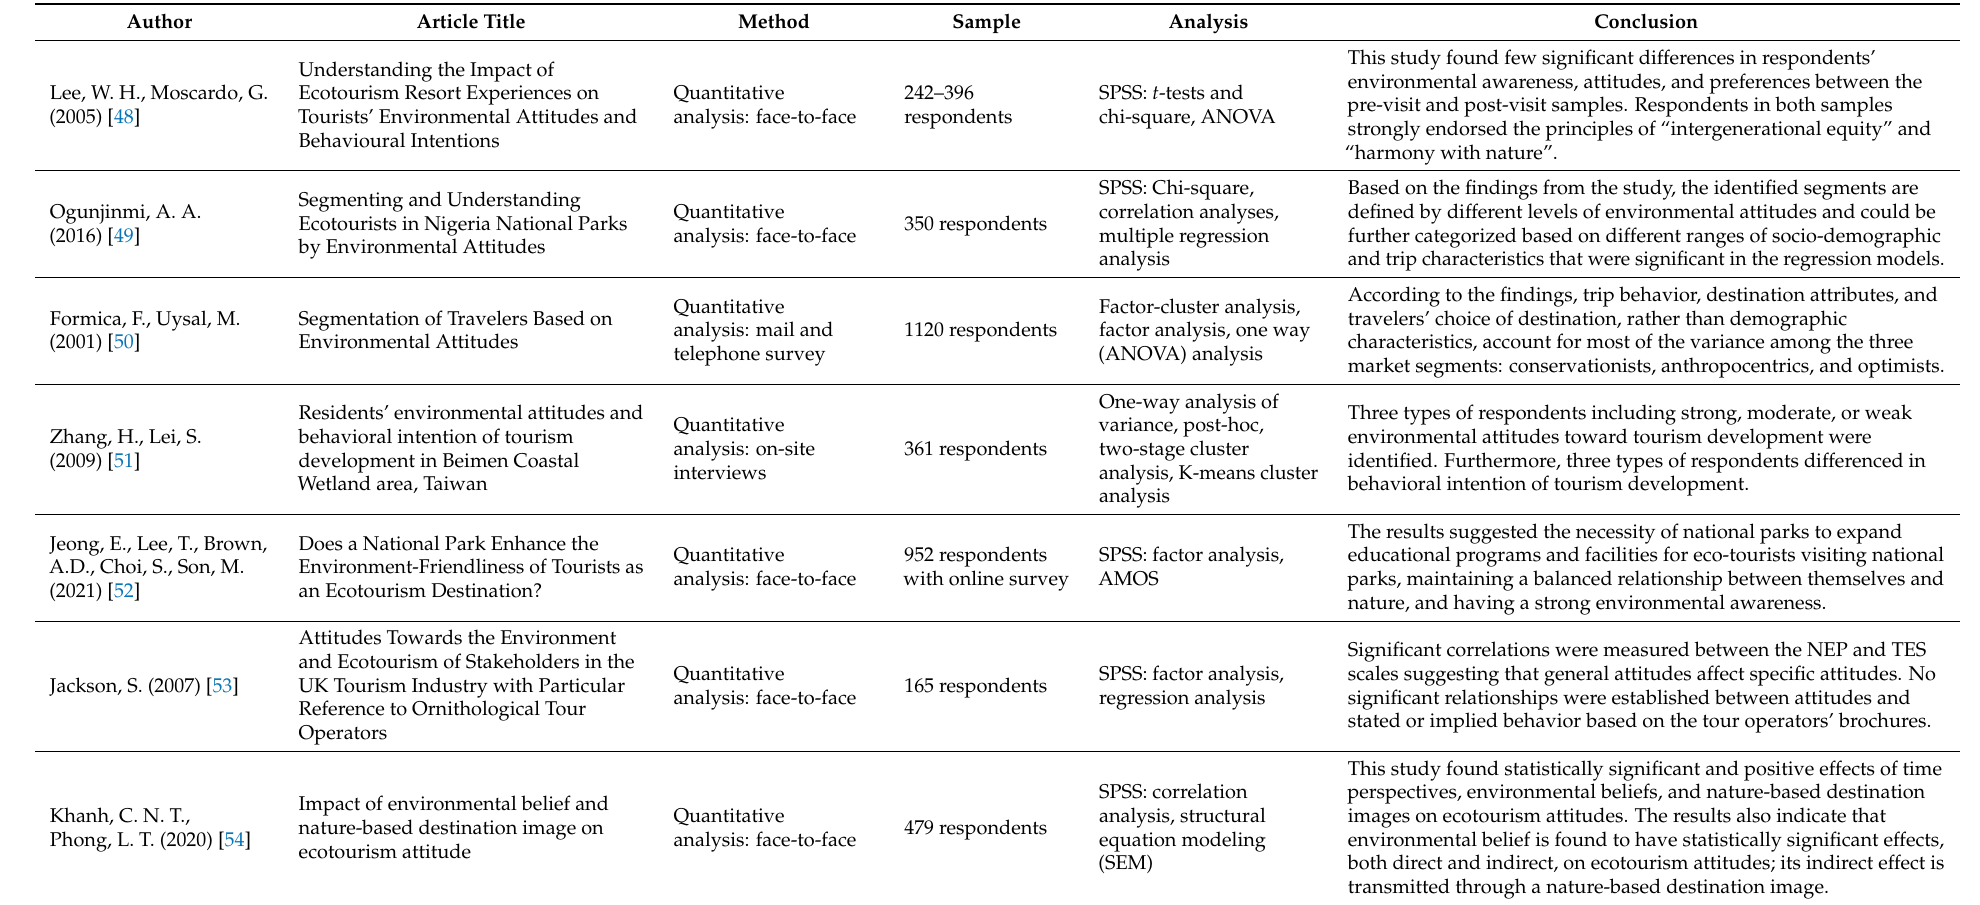
Table 2. Summary and comparison of related studies in the field of NEP and